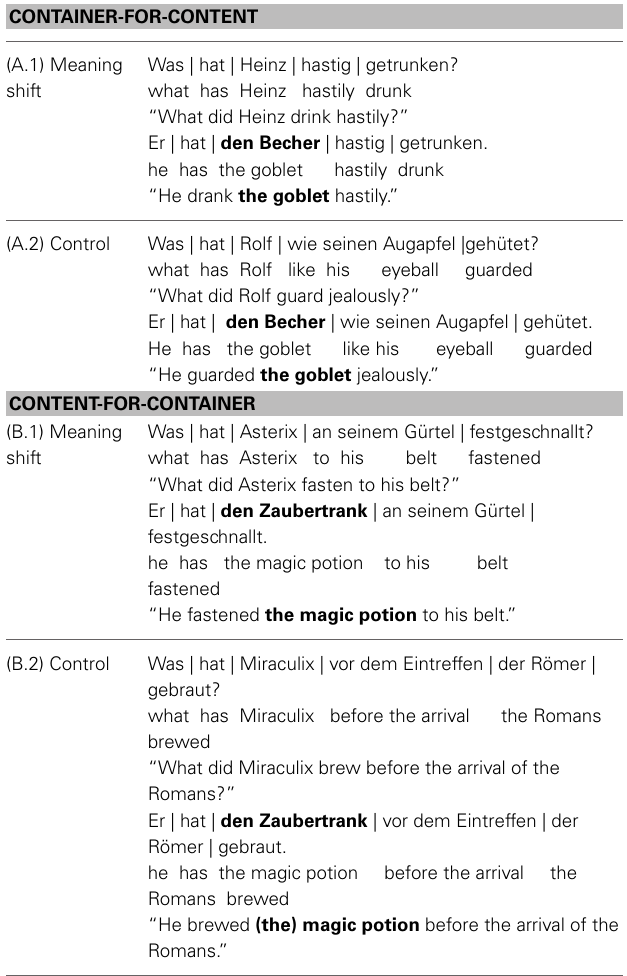
Table 1 | Sample stimuli for Experiment 1. Table 2 | Mean plausibility ratings for items from Experiment 1; standard deviations in parentheses (1, plausible; 5,